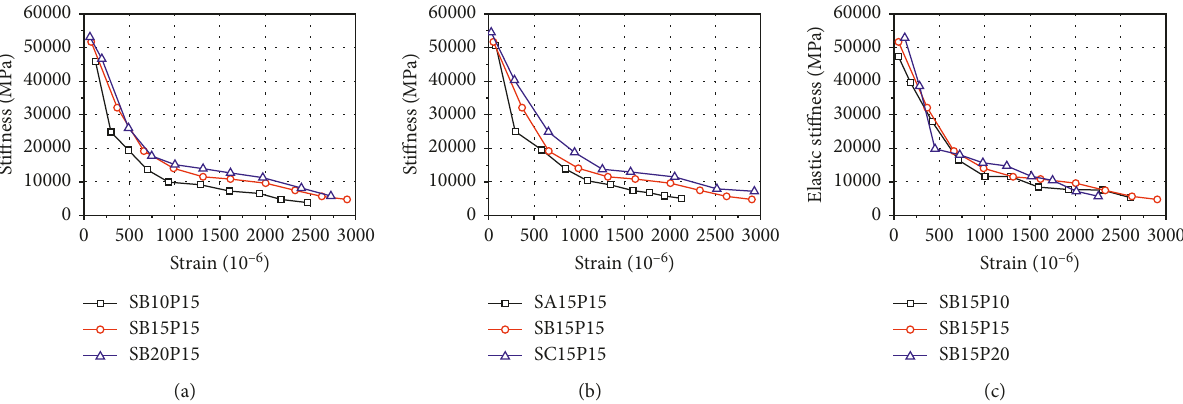
Figure 9: Stiffness degradation process of HFRC under cyclic tension: (a) effect of volume fraction of SF; (b) effect of aspect ratio of SF; (c) effect of volume fraction of PF.